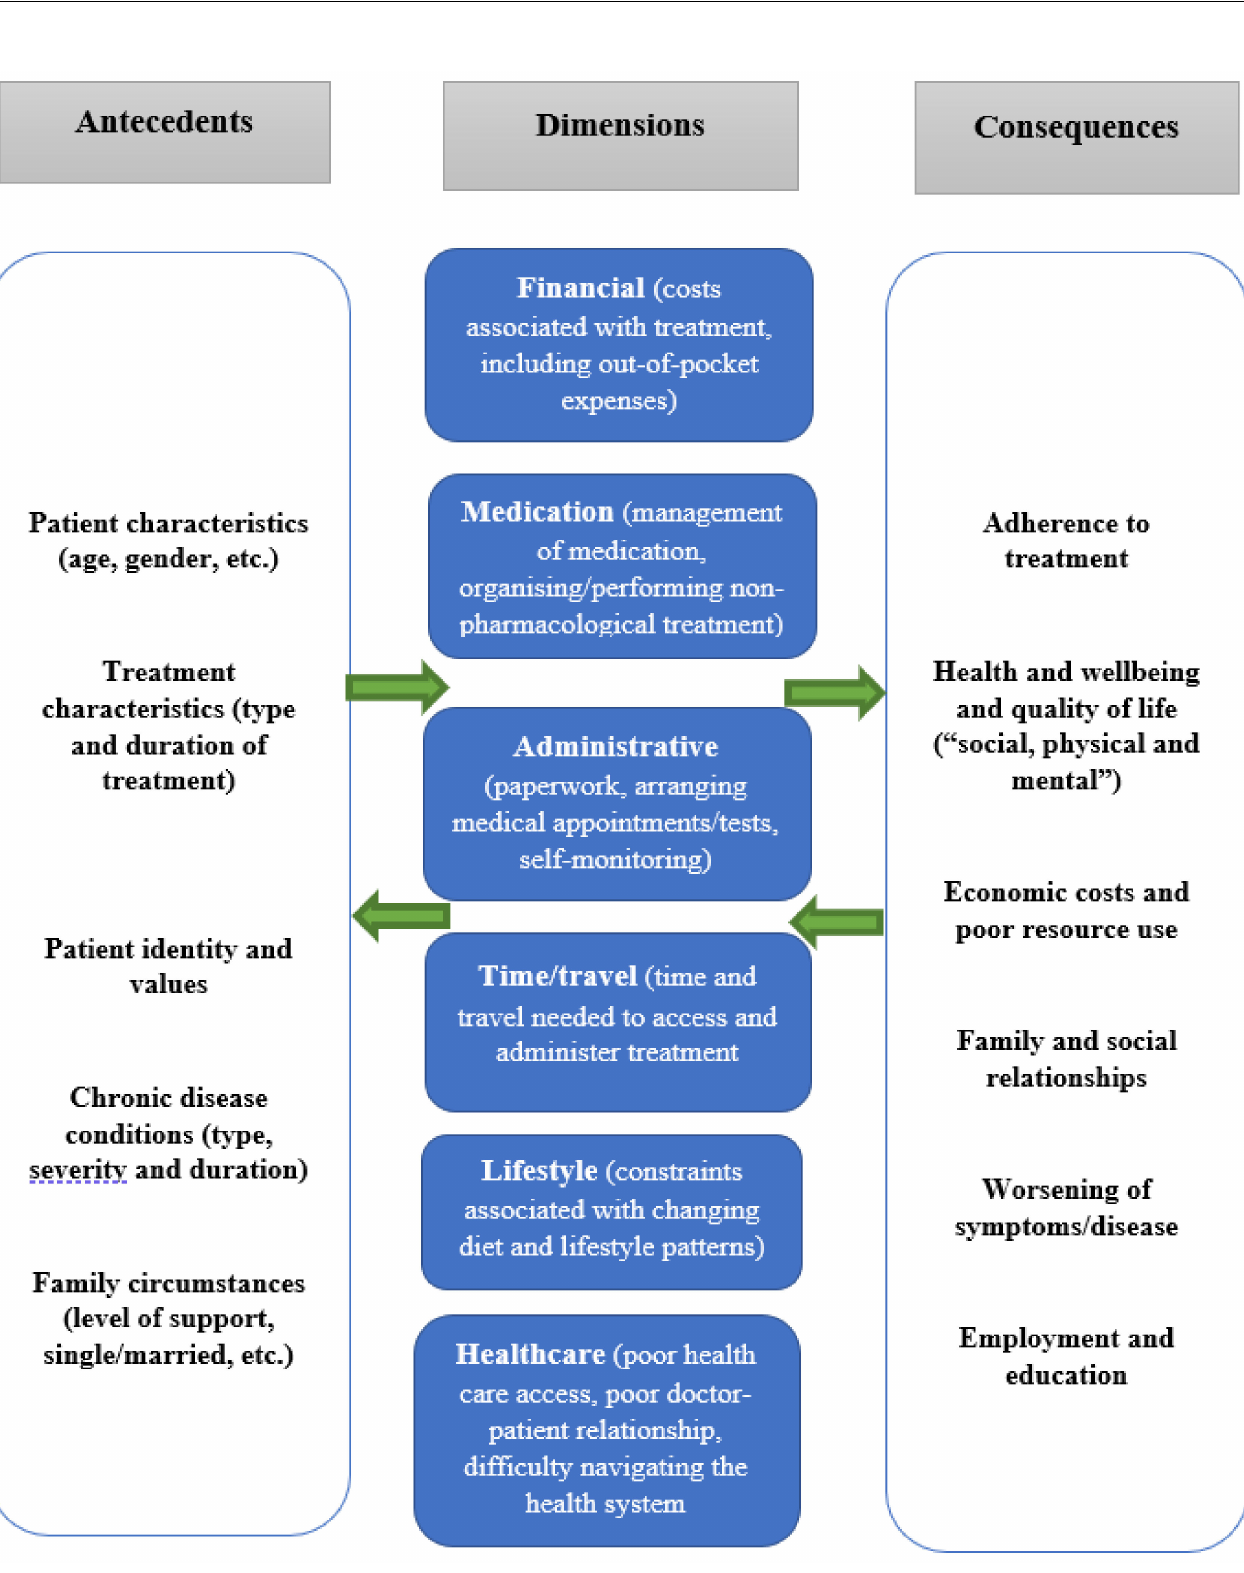
Figure 1. Conceptual framework of treatment burden (based on Sav et al.,